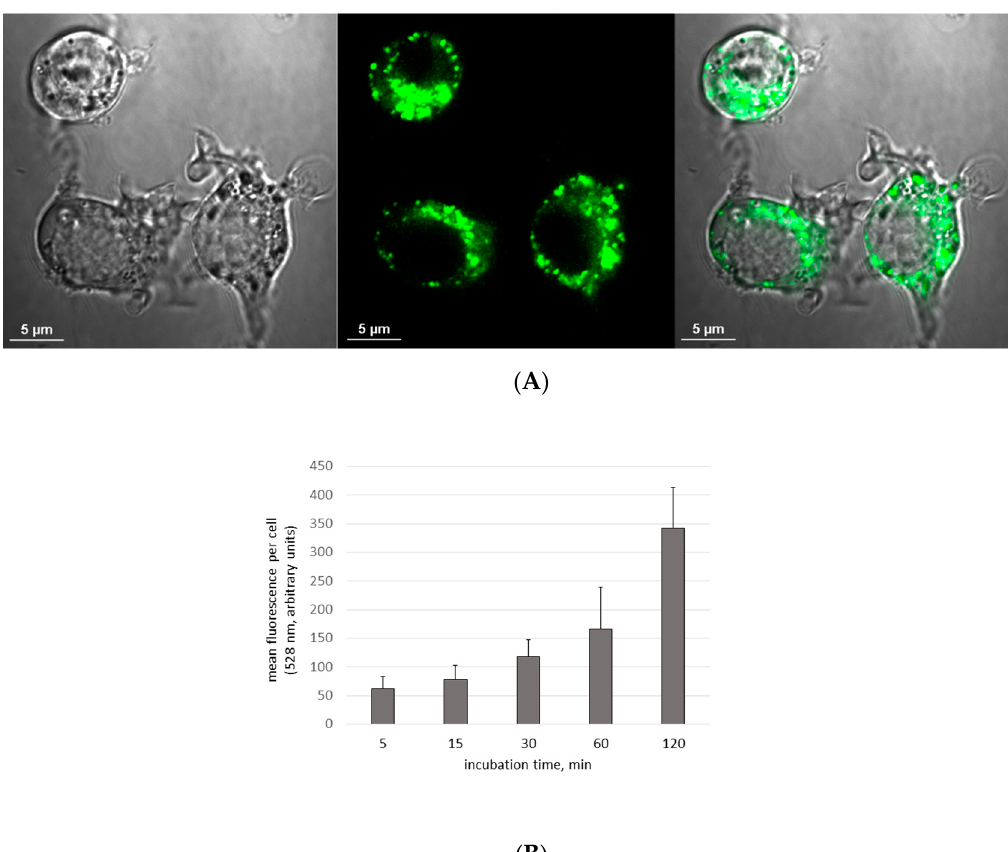
Figure 1. Uptake of A β by BV ‐ 2 cells. ( A ) Confocal microscopy image after 60 min incubation with A β‐ HiLyte Fluor 488. Magnification 100×. From left to right: DIC (differential interference contrast) microscopy, A β‐ HiLyte Fluor 488 fluorescence, merged. ( B ) Kinetics of A β uptake by microglial cells . BV ‐ 2 cells were incubated with A β‐ HiLyte Fluor 488 (0.1 µM) for 0, 5, 15, 30, 60 and 120 min. Fluorescence intensity at 528 nm was measured in six randomly selected cells using confocal microscope. Mean ± SD.